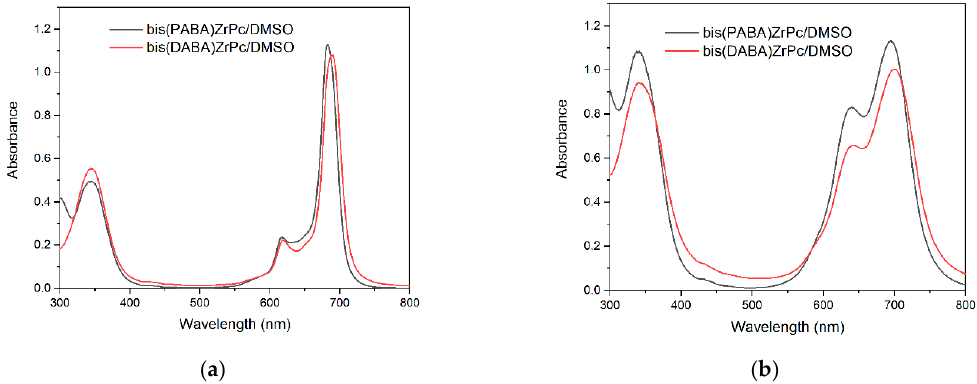
Figure 4. Absorption spectra of studied phthalocyanine complexes in ( a ) dimethyl sulfoxide (DMSO) and ( b ) saline. Molar concentration = 2 × 10 − 5 M.